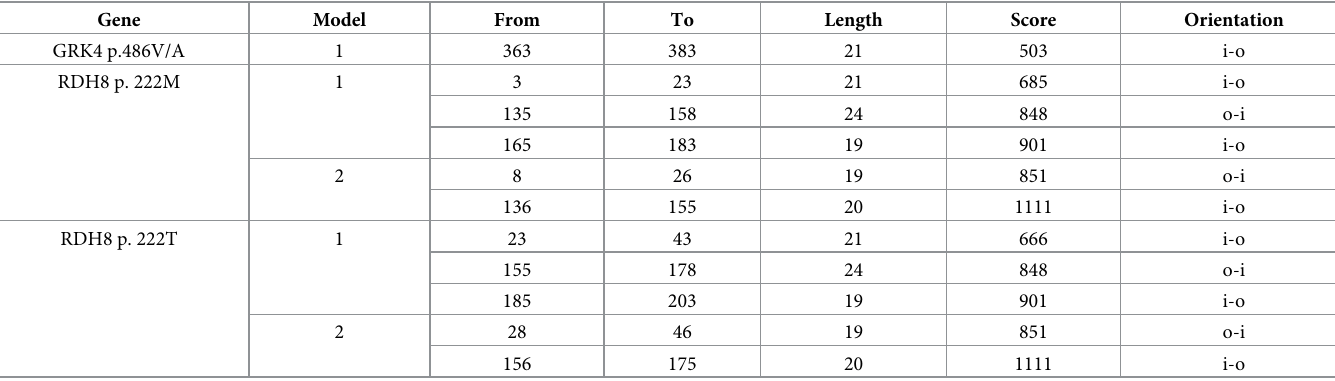
Table 2. Distribution of transmembrane domains before and after GRK4 and RKH8 site mutations. Gene Model From To